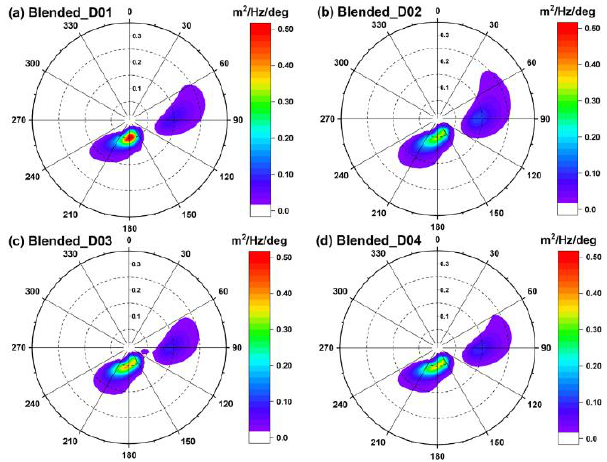
September 2016, using the four computational domains ( a – d ) and blended wind fields.